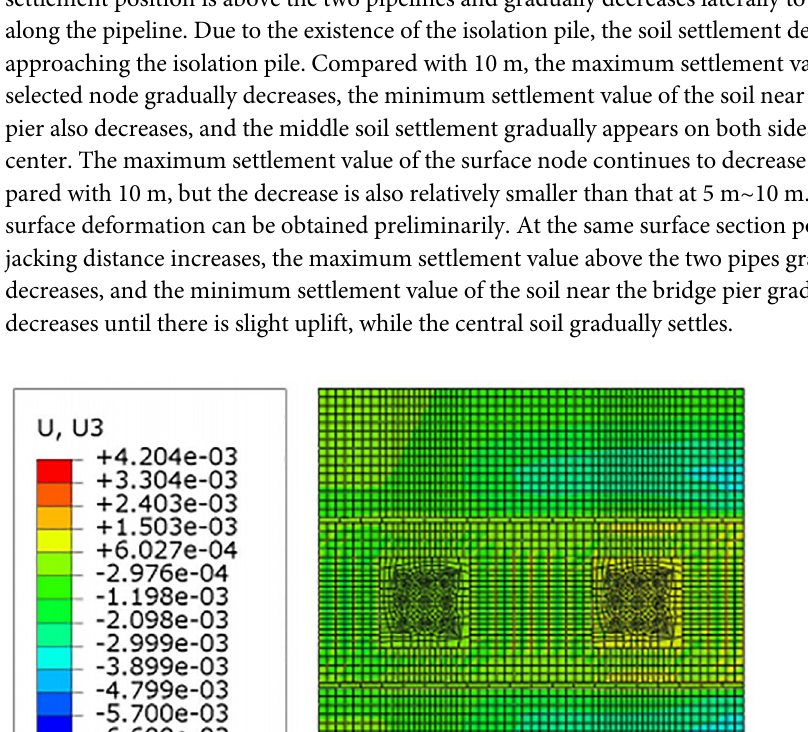
Fig 12. Model surface deformation clouds of loess-like soils at pipe jacking up to